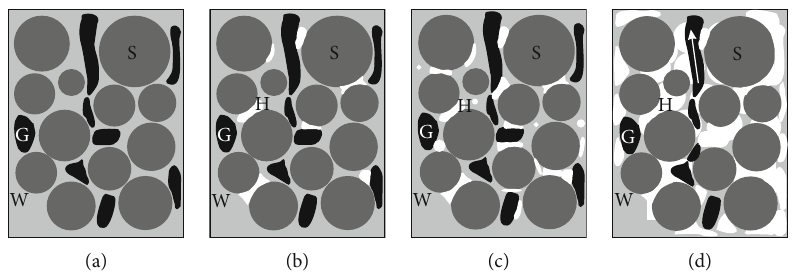
Figure 10: Hydrate morphology in a high methane leakage system. (a) No hydrate. (b) Hydrates fi rst form on the surface of gas bubble and at grain contacts. (c) Hydrates form across the entire sample (mainly formed in the grain contact, a small amount is formed in the pore fl uid). (d) The end of hydrate formation (with a methane leakage channel). S represents the sand grain. W represents water. H represents gas hydrate. G represents methane